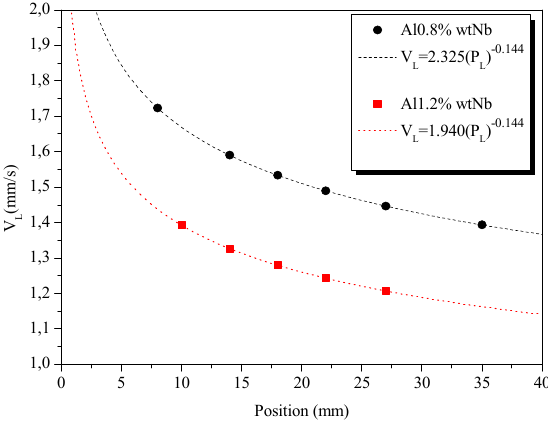
Figure 3. Speed of the liquidus isotherm.